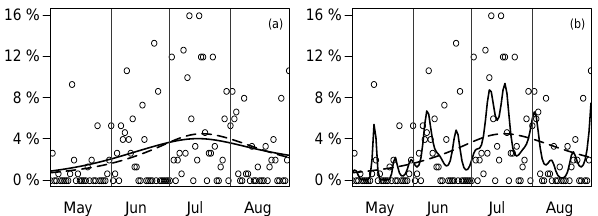
Figure 9. Local fits for the location E. Circles show empirical esti- mates. For comparison the estimate of the full occurrence model is added (dashed line). (a) Solid line is the GAM evaluated by cross- validation with day-wise blocks. (b) Solid line is the GAM evalu- ated by cross-validation without day-wise